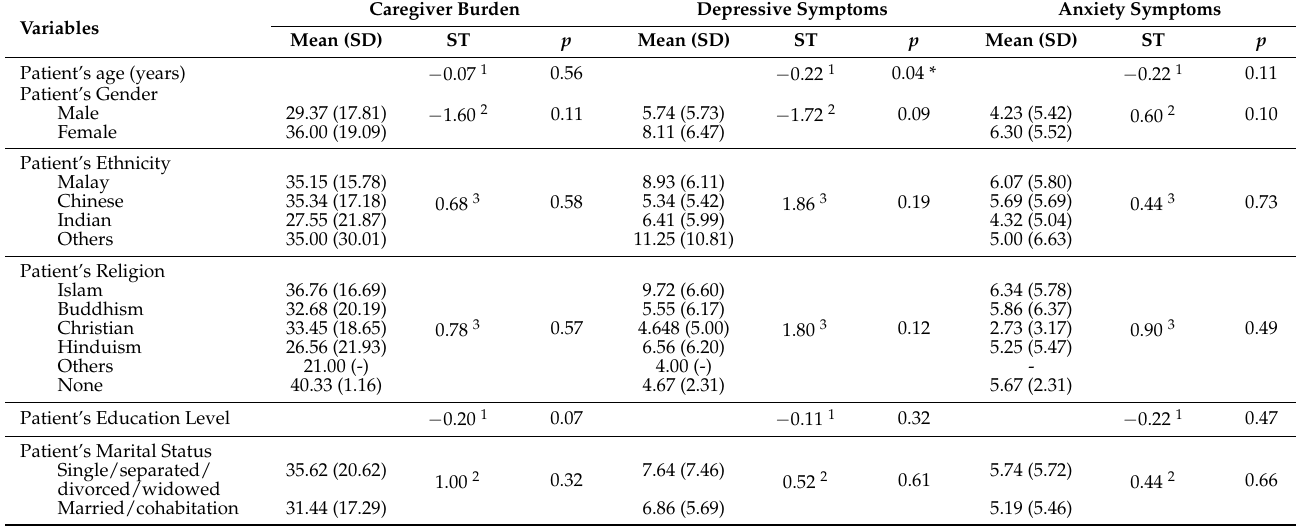
Table 6. Relationships Between Patient Sociodemographics and Caregiver Burden, and Depressive and Anxiety Symptoms.in Caregivers of PwD.